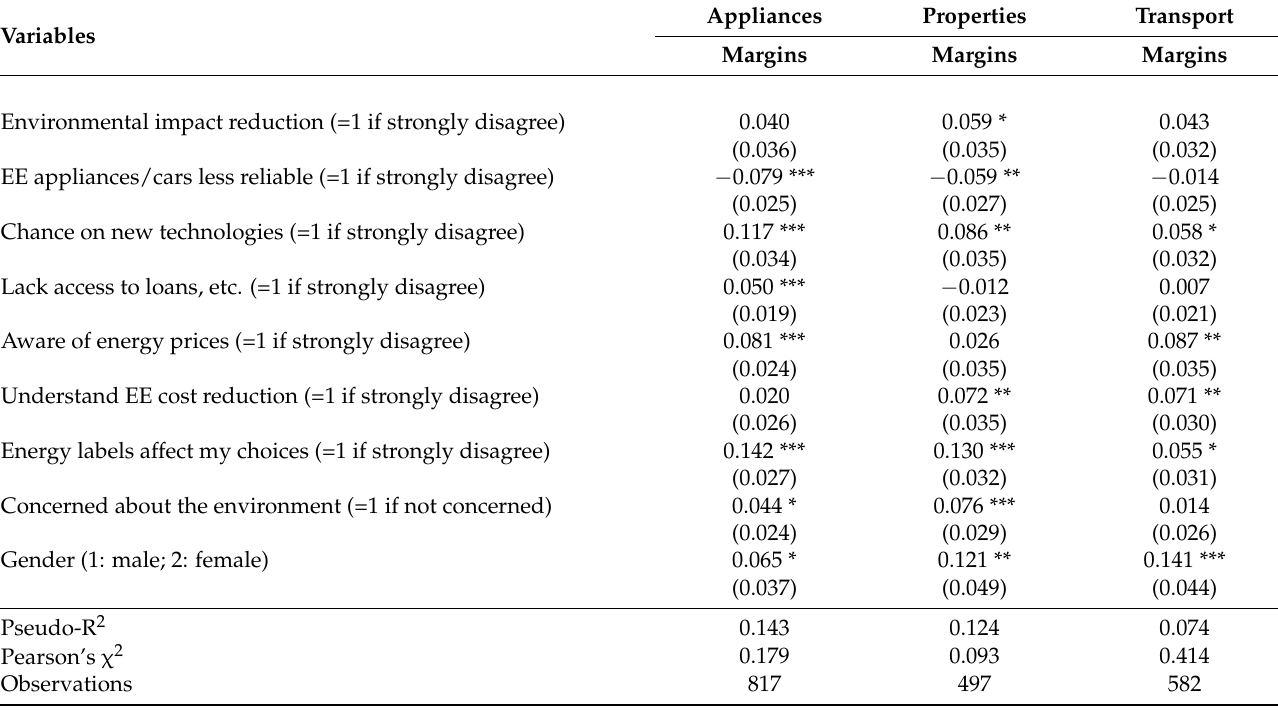
Table 6. Variables affecting households’ perceptions of energy efficiency—probit marginal effects (technology subsamples). Variables